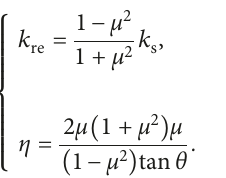
Figure 3: Force balance of the passive variable friction damper: (a) overall force balance of the slider and extrusion block; (b) force balance of the isolated sliding and extrusion